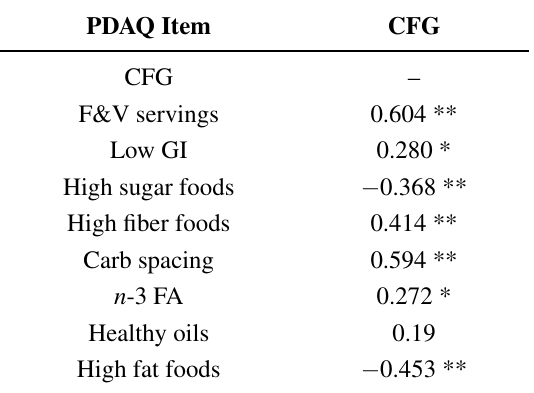
Table 4. Spearman rank-order correlations between frequency of following Canada’s Food Guide and other items in the Perceived Dietary Adherence Questionnaire